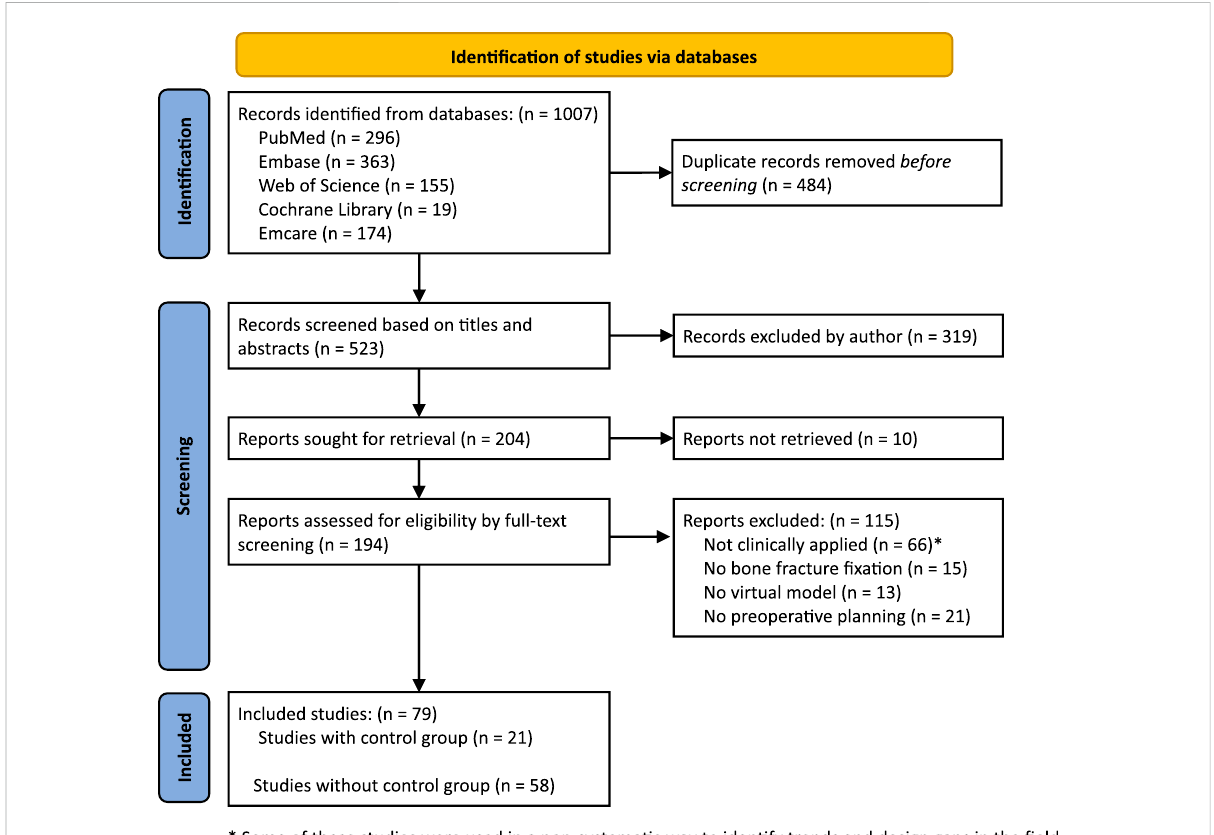
FIGURE 2 PRISMA fl ow diagram of literature search